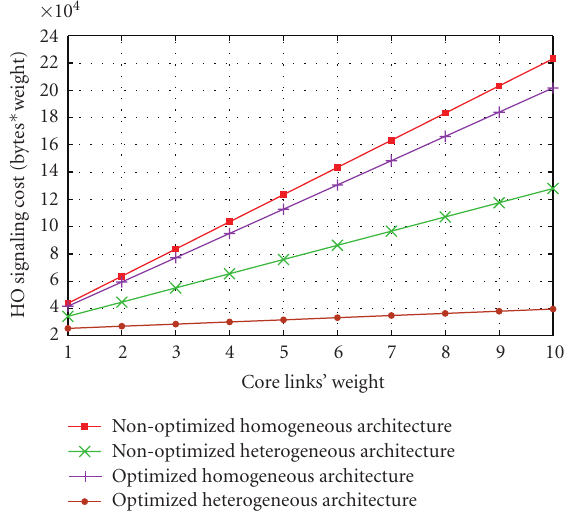
Figure 16: Core Link weight e ff ect on HO signaling cost.